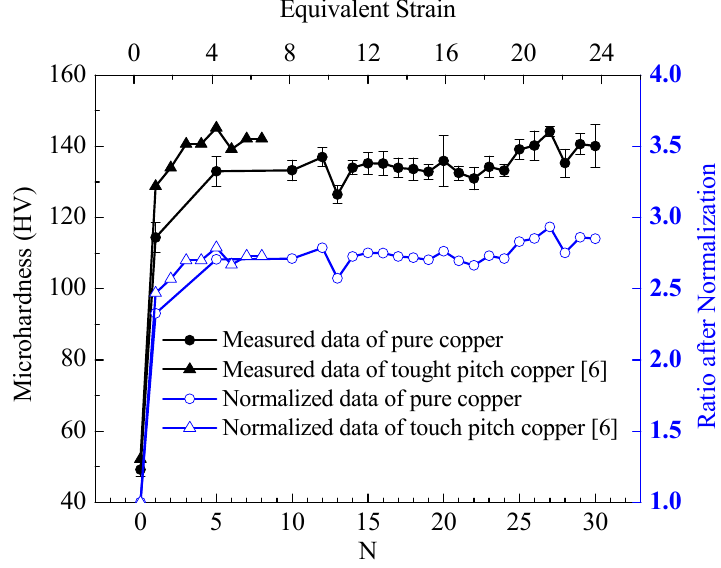
Figure 3. Microhardness of ARBed Cu in the present study and ARBed tough pitch copper [6] as functions of N and corresponding equivalent strain, before and after normalization.